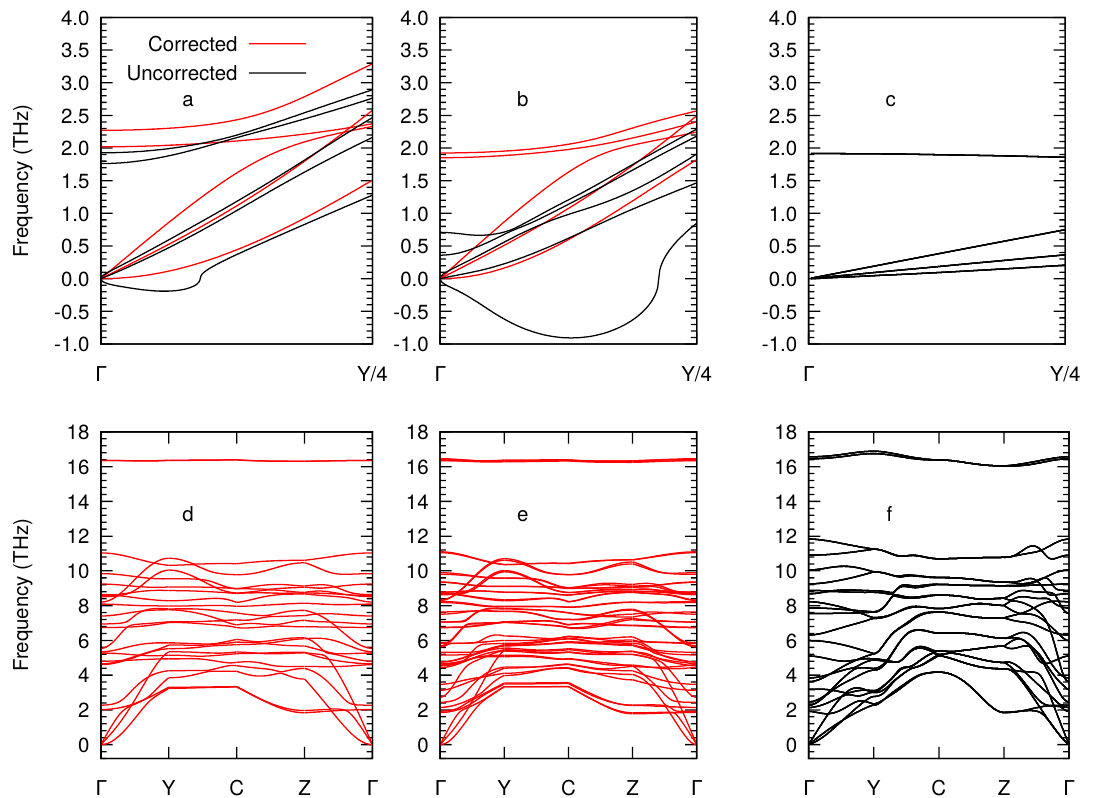
Figure 3. Zoomed phonon dispersions along the Γ -Y direction before and after correcting the harmonic IFCs according to the procedure given in Ref. [18] for the monolayer ( a ) and bilayer ( b ) as well as the uncorrected spectra for the bulk ( c ). Full corrected dispersion relations for the monolayer ( d ) and the bilayer ( e ) and uncorrected for the bulk ( f